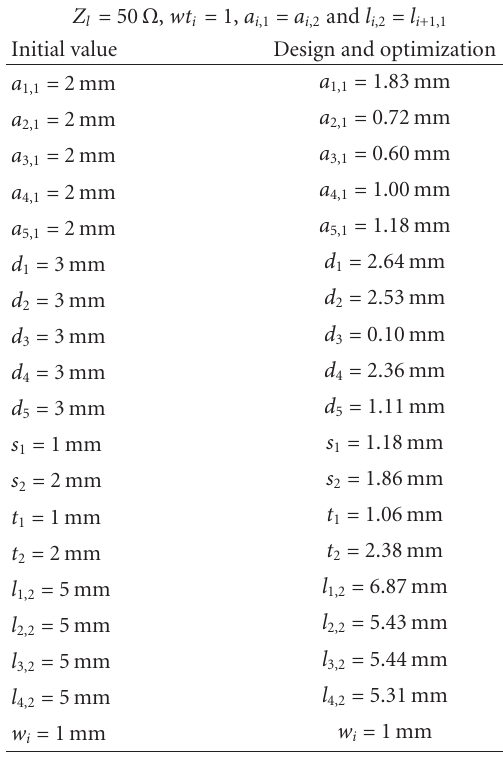
Table 3: Parameters of designed proposed multilayered microstrip hairpin filter (Example